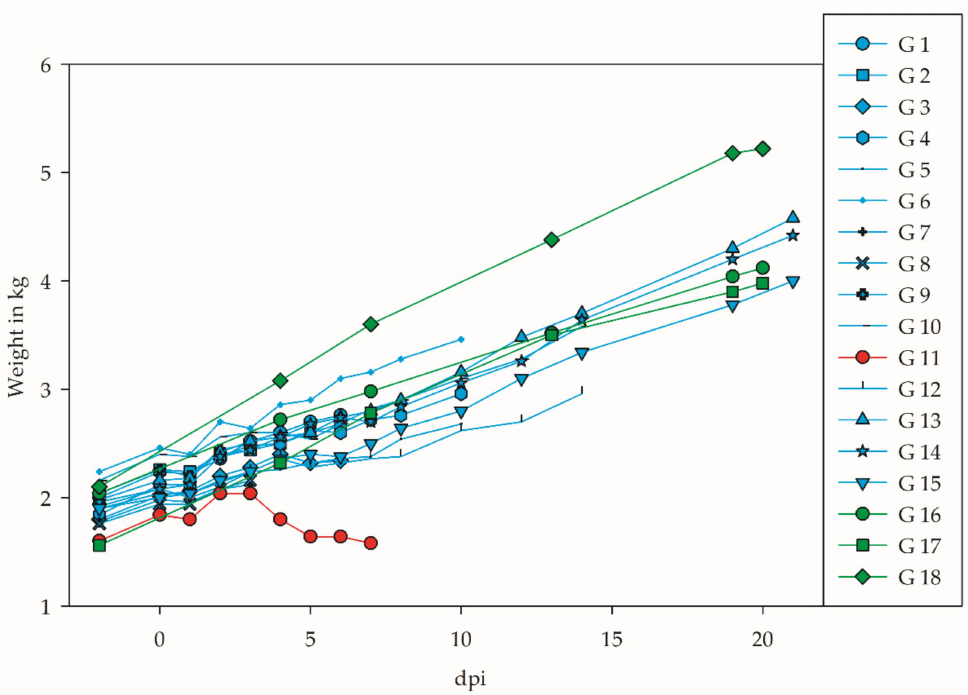
Figure 2. Weight gain of all geese throughout the experiment. Infected geese shown in blue, controls in green, and G 11 (severely diseased) in red.